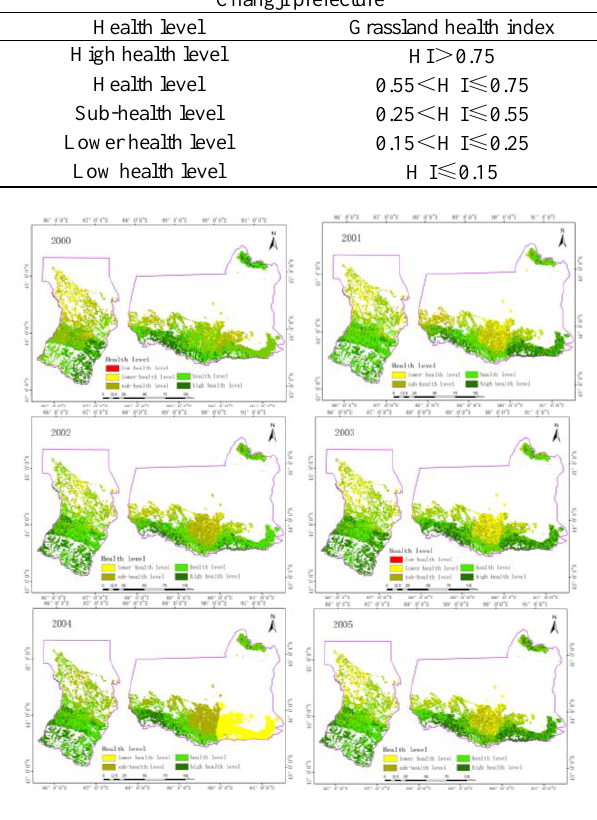
Table 2. Grade standard of grassland health assessment